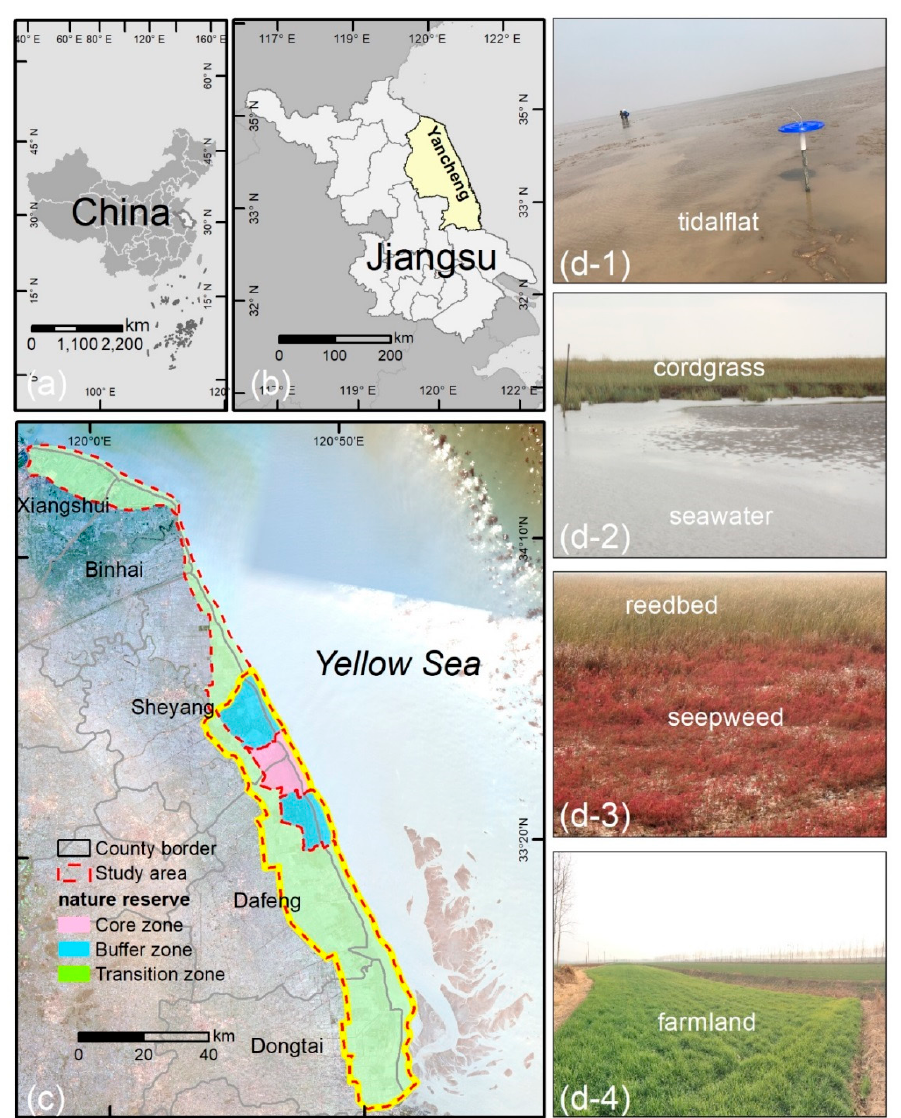
Figure 1. ( a – c ) Location of the study area. The main natural wetlands of the open coastal wetlands in Jiangsu (OCWJ) comprise tidalflat ( d-1 ); cordgrass and seawater ( d-2 ); seepweed and reedbed ( d-3 ); and farmland ( d-4 ) [42], an exotic introduction from North America which outcompeted the native wetlands and became a dominant species after 1990. The area bounded by the yellow line ( c ) is the spatial heterogeneity of landscape space.